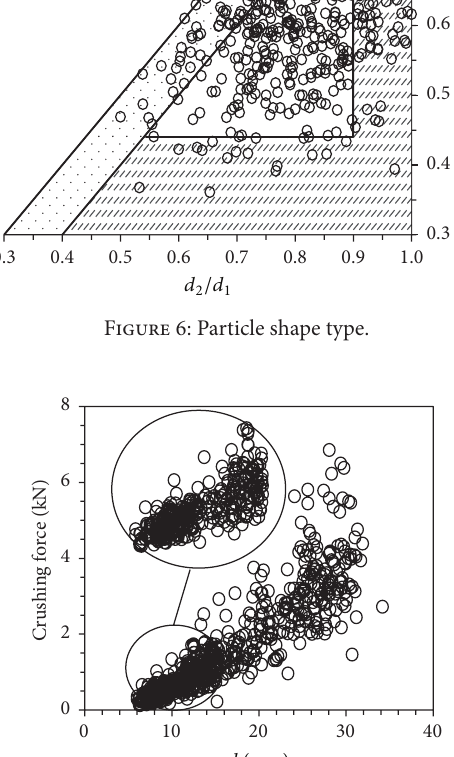
Figure 7: Relationship of crushing force and particle